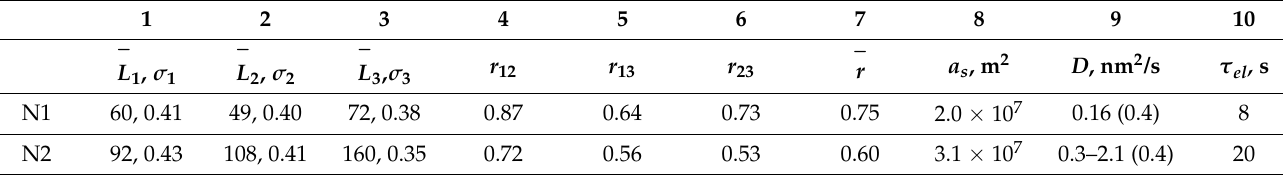
Table 6. Parameters of N1 and N2 samples. Column 1—parameters of crystallites, average size L 1 (nm) and variance σ 1 of Lognormal distribution along the [010] axis, etc. and columns 2, 3—parameters for [100], [001] axes. Columns 4–6 are the correlation coefficients, while 7 are their average values. Column 8 shows the total area S of the cross sections of crystallites on the (010) plane, 9 shows the diffusion coefficients, 10 is the electrical relaxation time (see Section 6.2